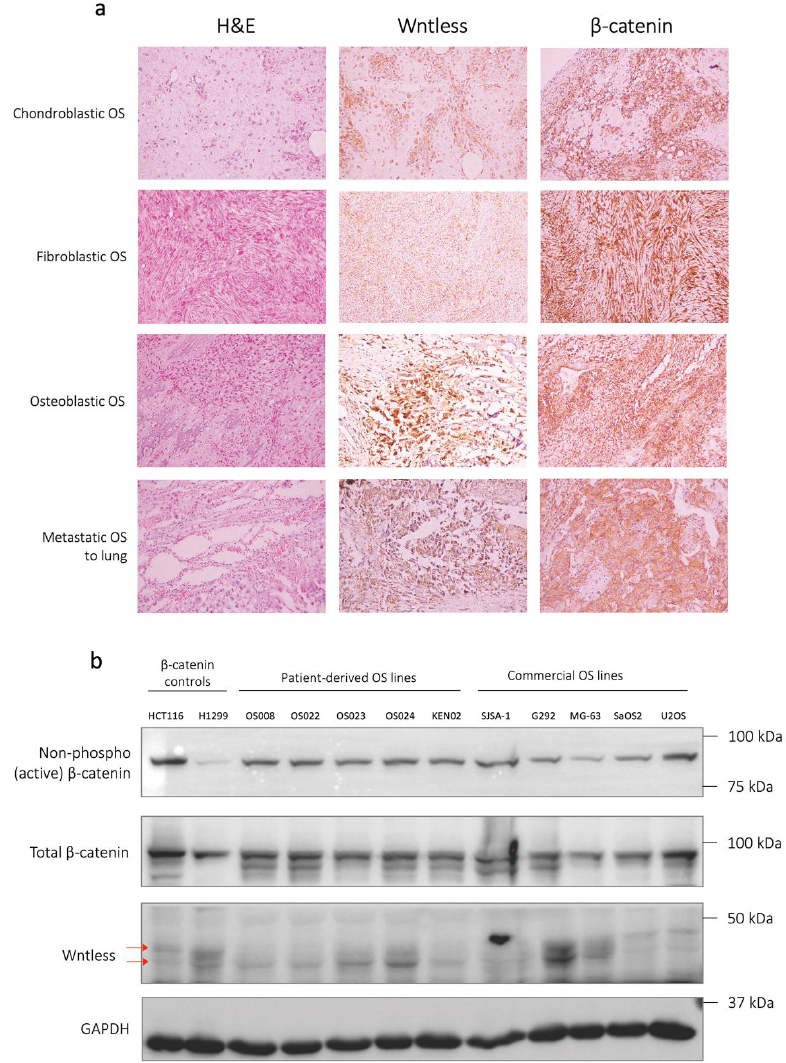
Figure 1. The Wnt signalling pathway is elevated in OS patient samples. ( a ) Haematoxylin and eosin (H&E) and IHC scans of clinical OS tumour samples showing strong staining of WLS and β -catenin. Images taken at 200× magnification. ( b ) Western blot performed for non-OS cell lines (HCT116 and H1299), established OS PDC lines, and commercial OS cell lines against non- phospho (active) β -catenin, total β -catenin, WLS (clone YJ5, arrows refer to the double band of WLS).